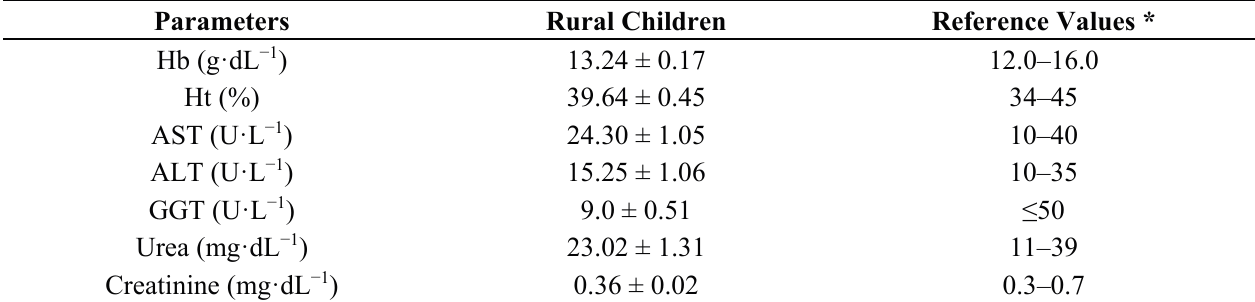
Table 1. Hematological and biochemical parameters in rural children ( n =